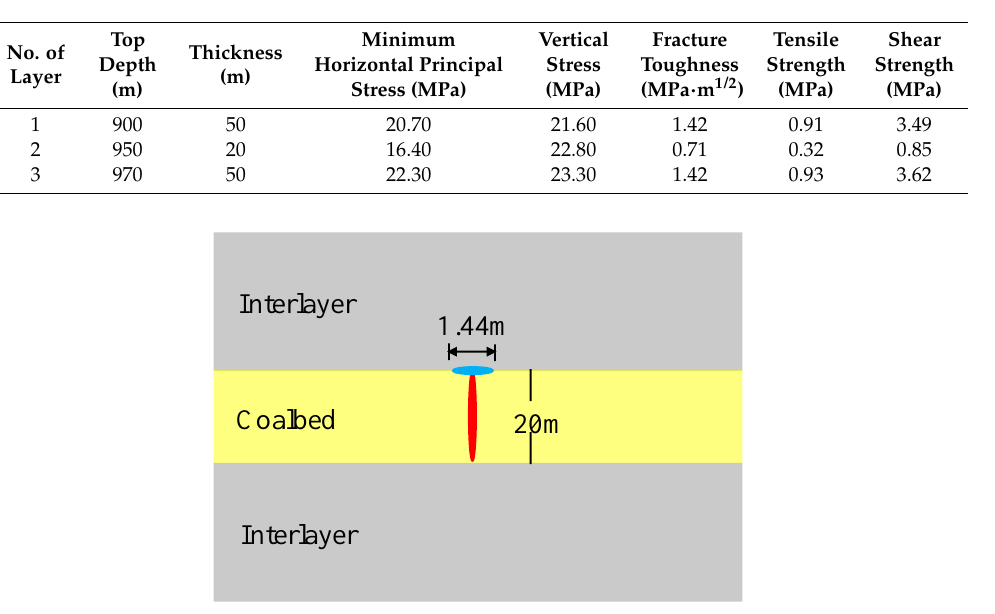
Table 3. Assumptions for the analysis of the influence of T-type fracture.